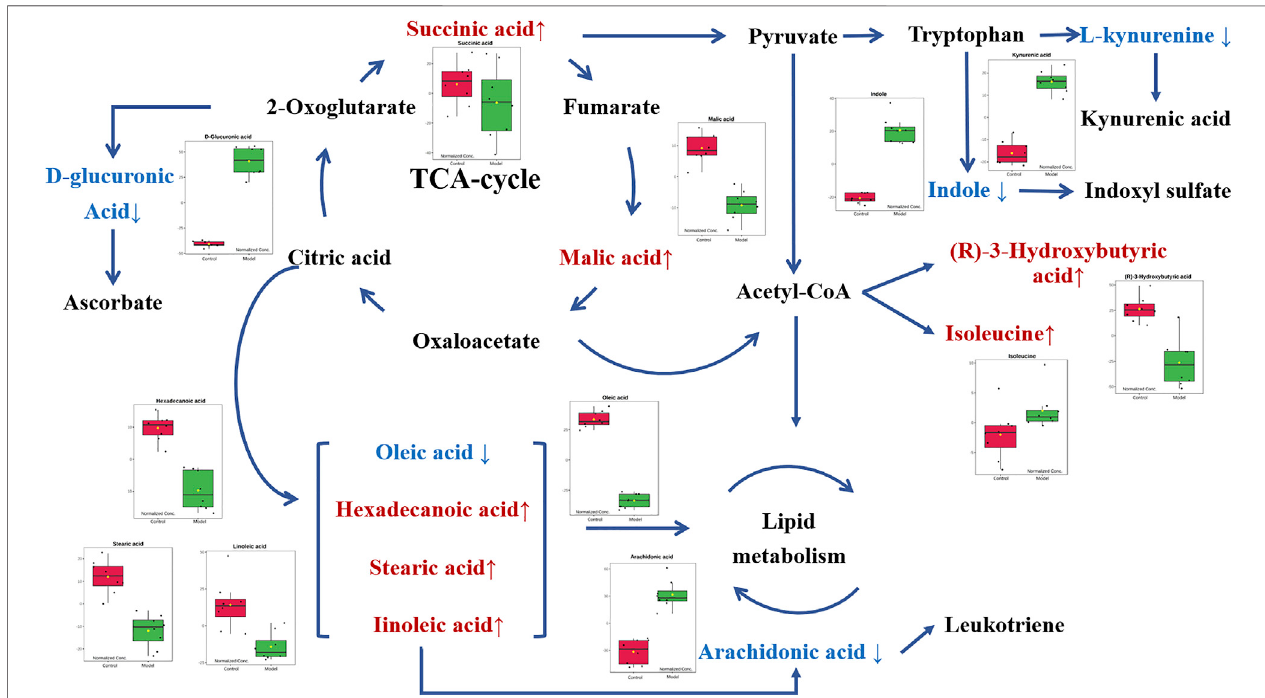
FIGURE 6 | Metabolic networks of potential biomarkers in rat serum. Note: Metabolites in red and blue represent levels increased and decreased in the Model group, respectively.